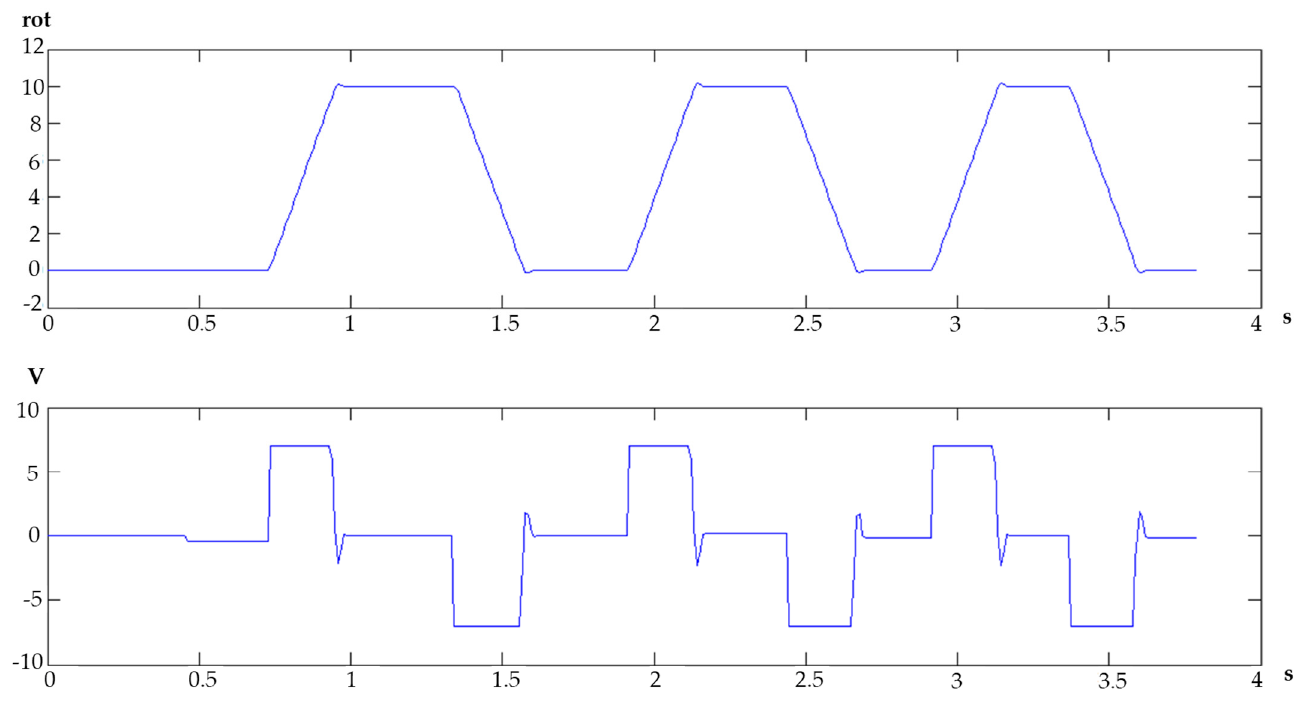
Figure 6. Tension inputs for settling time achieve.